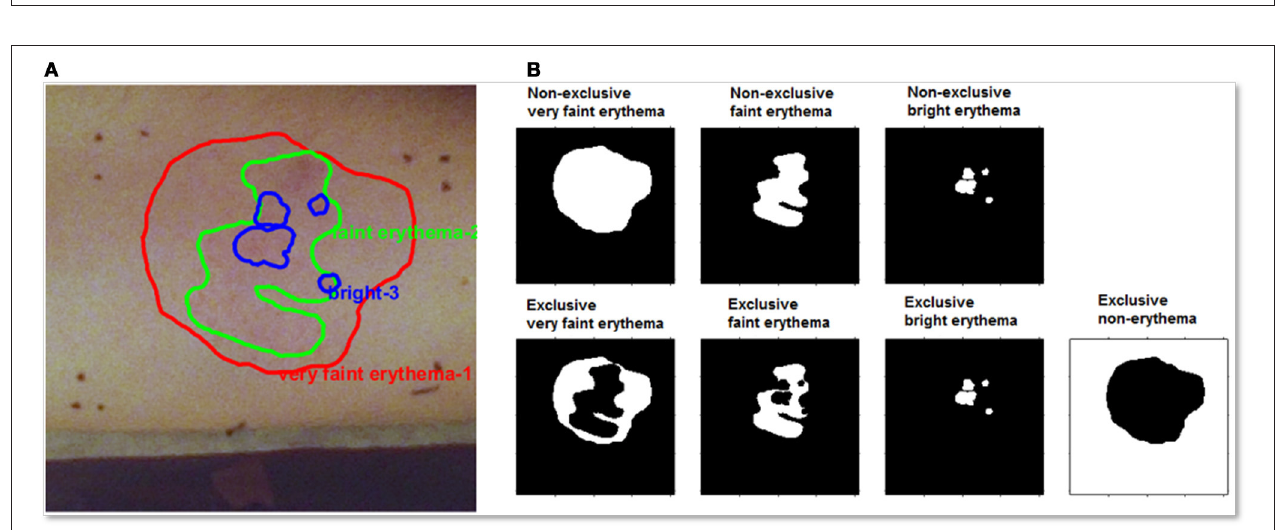
FIGURE 4 | Overview of the image processing